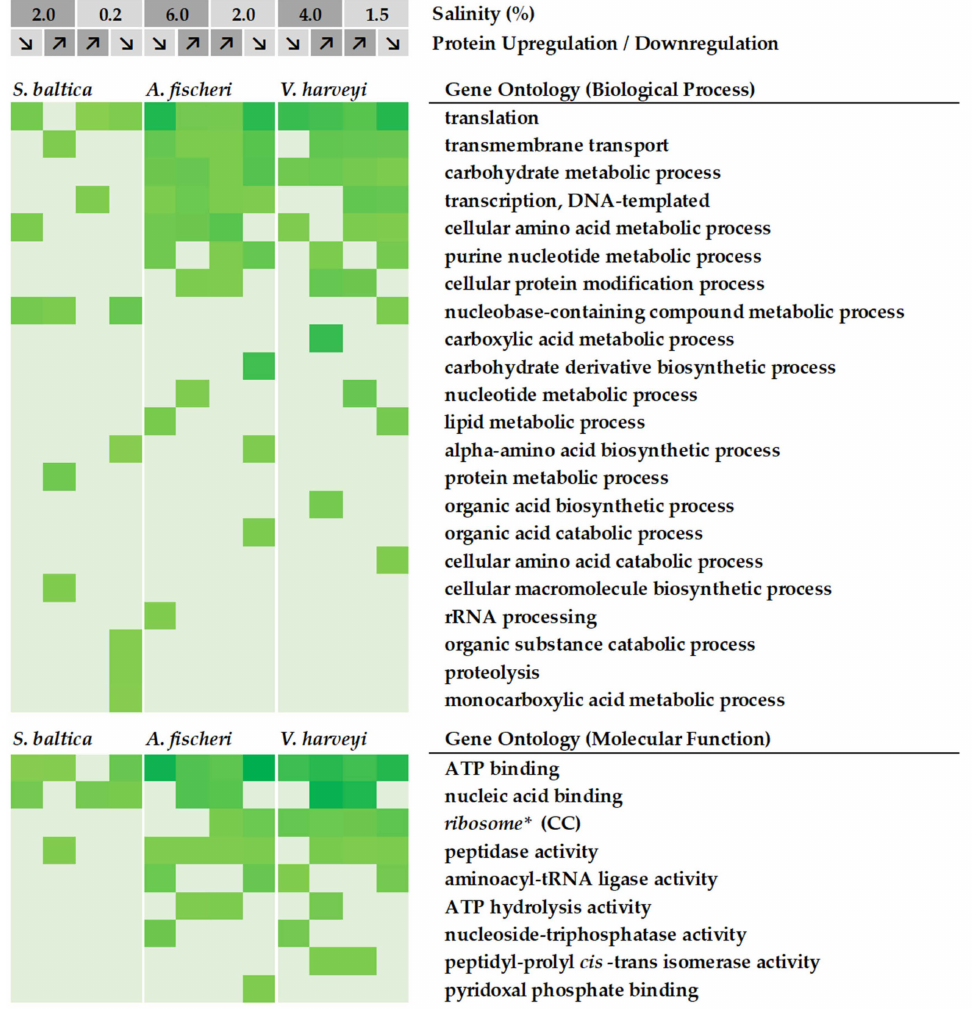
Figure 5. Summary of gene ontology analysis of proteins with differential abundance in S. baltica , A. fischeri and V. harveyi in response to salinity stress. Gray boxes indicate higher (Hi)- and lower (Lo)-than-optimal salinity conditions; the upwards- and downwards-pointing arrows indicate up- and down-regulation of proteins in each bacterium and condition. The hue of green color indicates the number of proteins that were obtained in annotation analysis shown in Figures 2–4. The upper part of the heatmap shows biological process ontologies, and the lower part shows molecular function ontologies; * indicates an exception—the ribosome which belongs to the cellular component (CC) ontology. The higher on the list the gene ontology term is listed, the more abundant that category is in